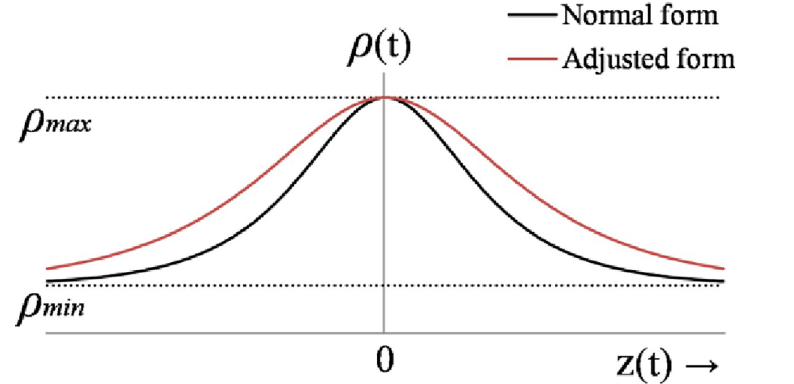
Fig 5. Automatic adjustment in the HSF waveform for the ACWF